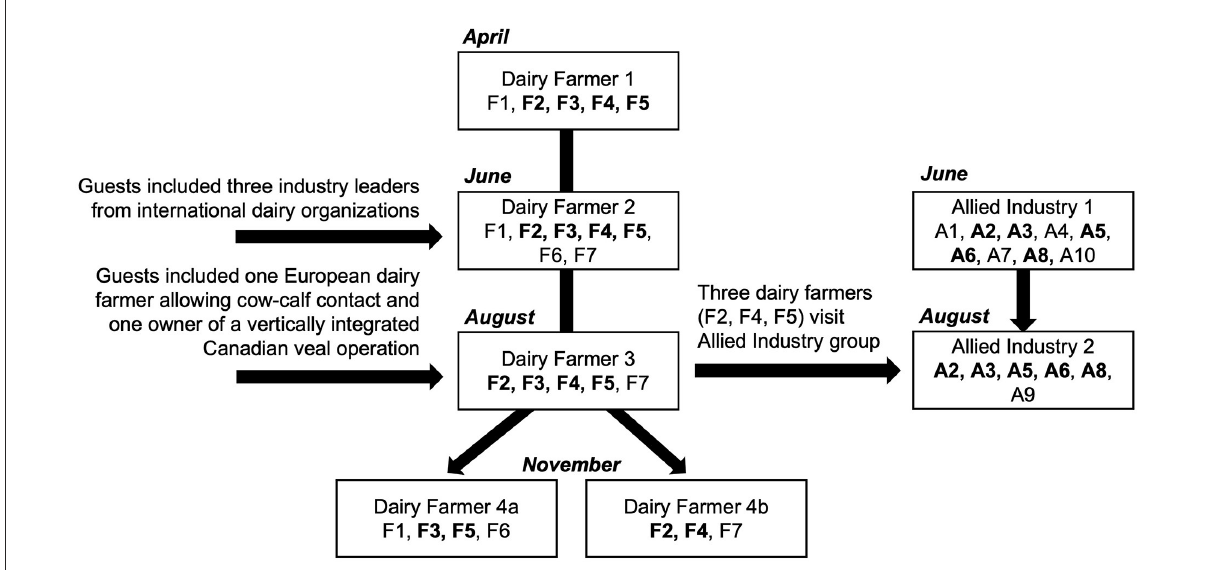
FIGURE1 Overview of virtual participatory group discussions held for dairy producers, allied industry and guests between April and November, 2020 to discuss surplus calves in Atlantic Canada. Bolded participants (F1–7 and A1–9) attended all meetings for their respective group.